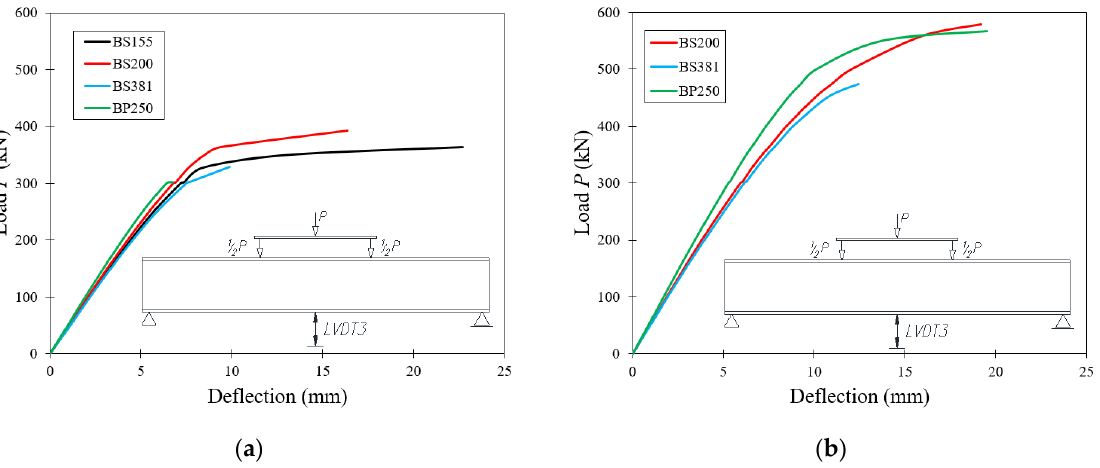
Figure 16. Comparison of deflection obtained during experimental testing of test samples with a web thickness of: ( a ) 3 mm and ( b ) 5 mm.